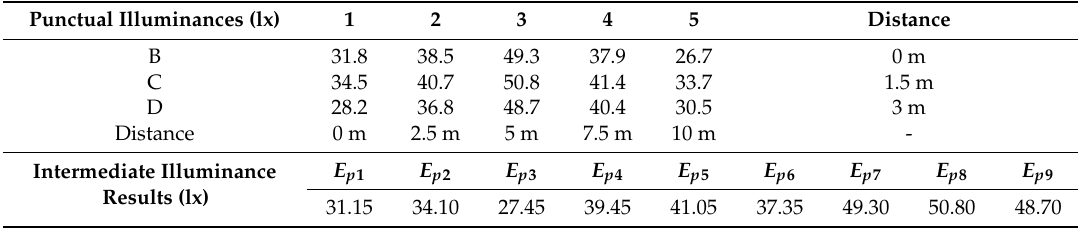
Table 8. Low-thickness enhanced translucent (C) cover field measurements and calculated parameters ( E pi ) used to obtain E m , U m , and U g .